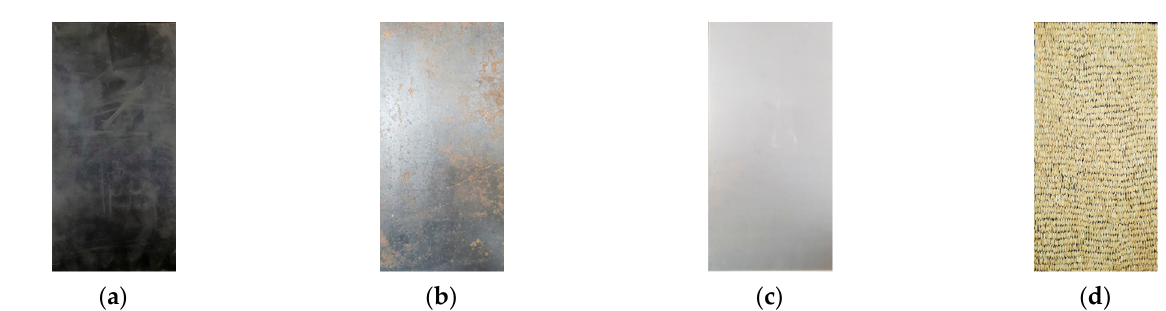
Table 2. The main parameters of instruments.